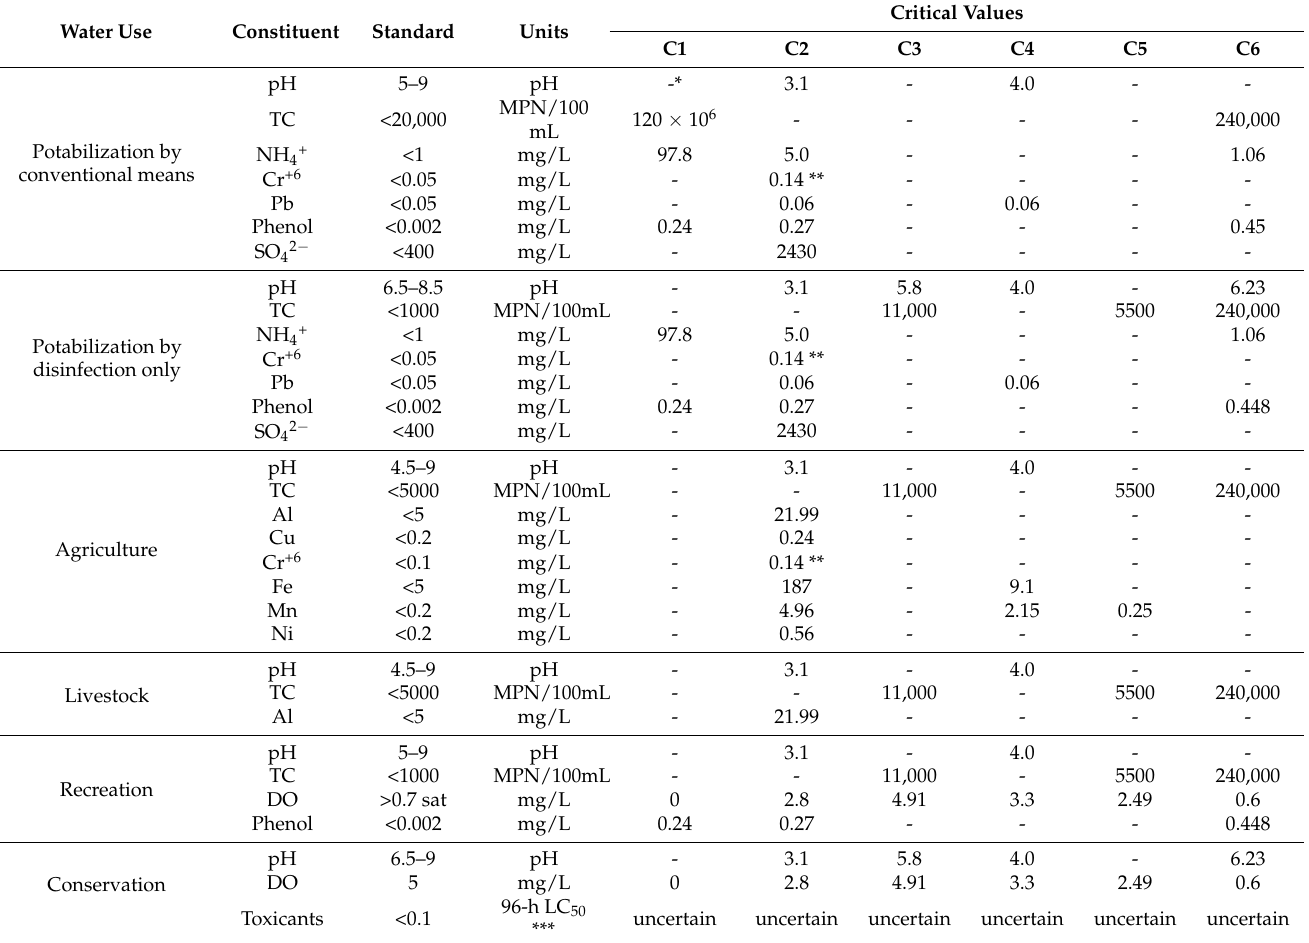
Table 7. Critical values for regulated constituents and uses of